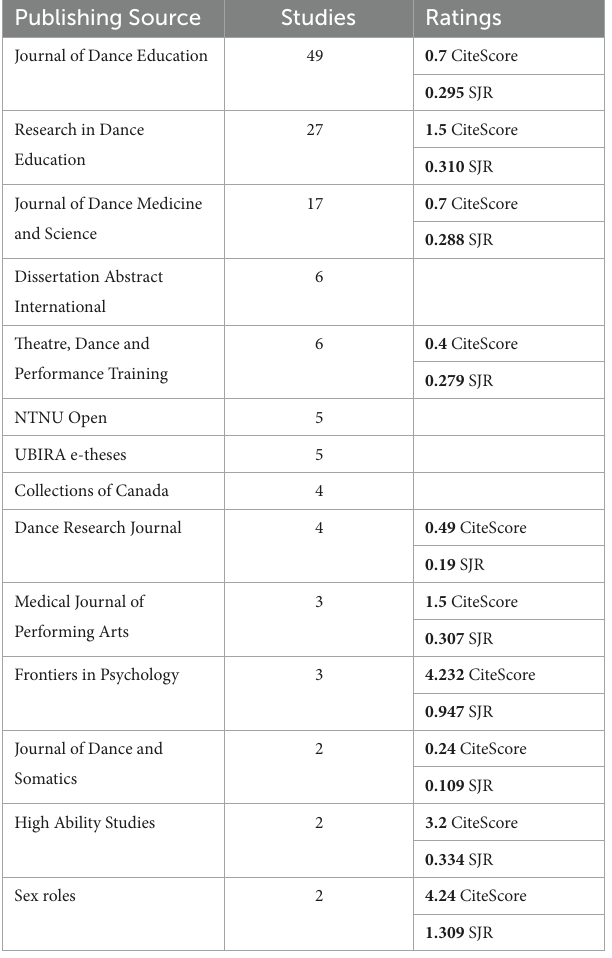
TABLE 2 Journals with more than one publication.